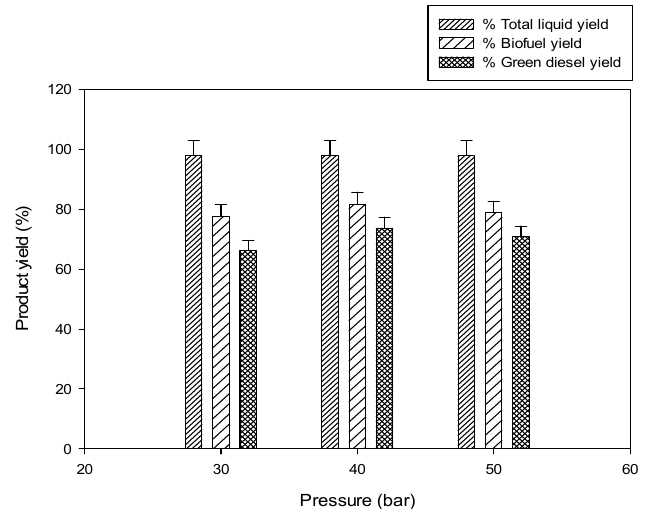
Figure 5. Effect of different initial hydrogen pressures (30, 40, 50 bar) during hydrotreating reaction.